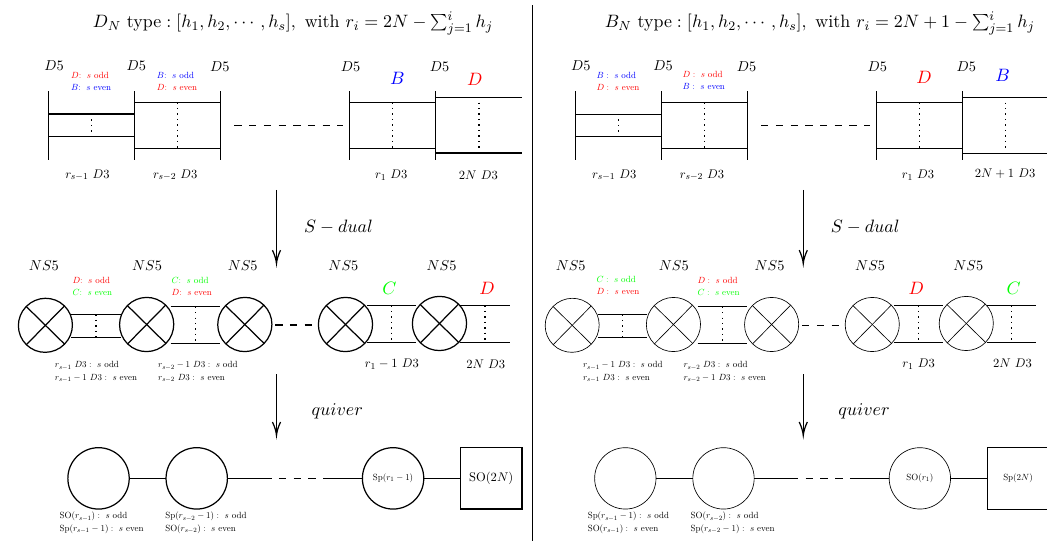
Figure 8 . Upper row: We construct a D 5 − D 3 brane system for a D type partition and B type partition respectively. There should be even number of D3 branes for a D type O3 plane, and odd number of D3 branes for a B type O3 plane. For a general D type or B type partition, the brane configuration would violate the rule for D type or B type O3 planes, and we add one more D3 brane so that the number is consistent with the corresponding O3 plane. Middle: We perform S duality on brane system in upper row, which turn a D5 brane to a NS5 brane, and D3 brane to a D3 brane. Bottom row: We read a quiver gauge theory from brane configuration of middle